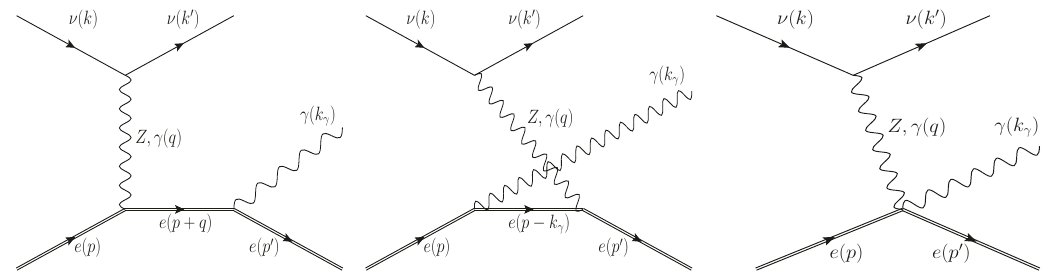
Figure 1 . Leading order Feynman diagrams for radiative neutrino scattering (1.11) on a “spinless electron”. Shown are the diagrams for νe scattering mediated by Z 0 exchange (NC weak interaction) or photon exchange (for scattering due to the neutrino magnetic or electric dipole moments). The latter case will be considered in section 2.2. For the CC weak interaction contributions, see the